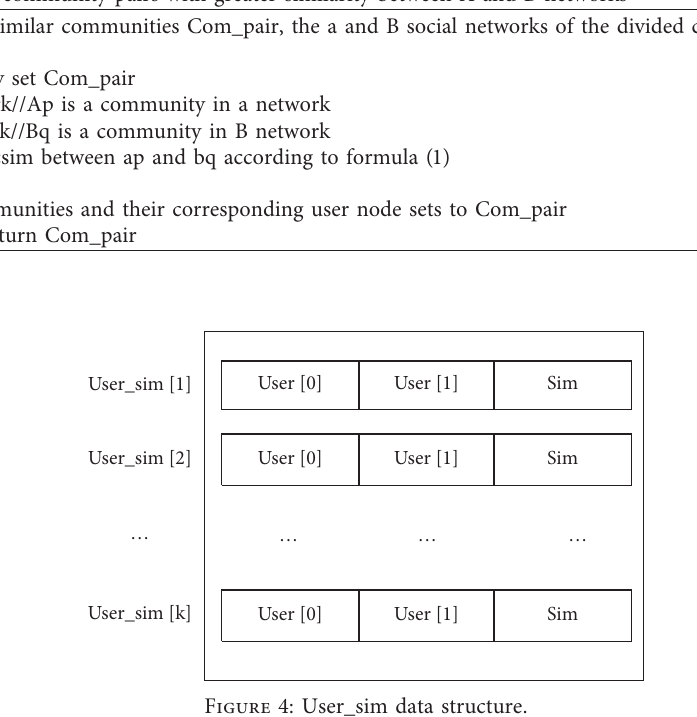
Figure 4: User_sim data